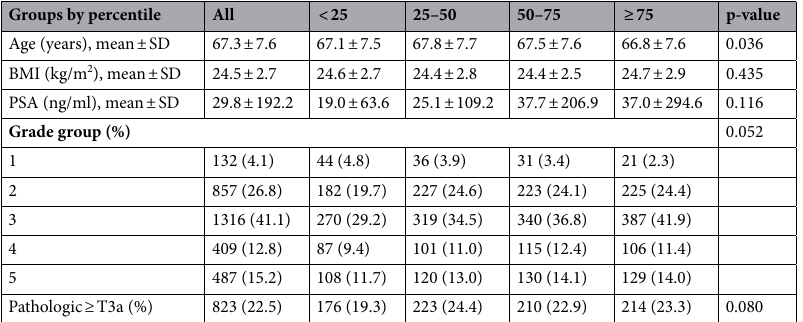
Table 1. Baseline clinical and pathologic characteristics. SD standard deviation, BMI body mass index, PSA prostate specific antigen.